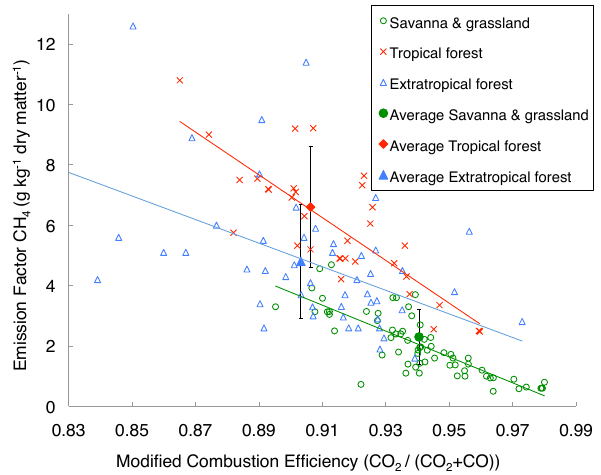
Fig. 2. Methane (CH 4 ) EFs and the molar-based modified combus- tion efficiency (MCE) for all available measurements, the biome- averaged values presented in A&M2001–2009, and regression lines. The error bar indicates the standard deviation as reported in A&M2001–2009. Regression coefficients for the different biomes can be found in Section